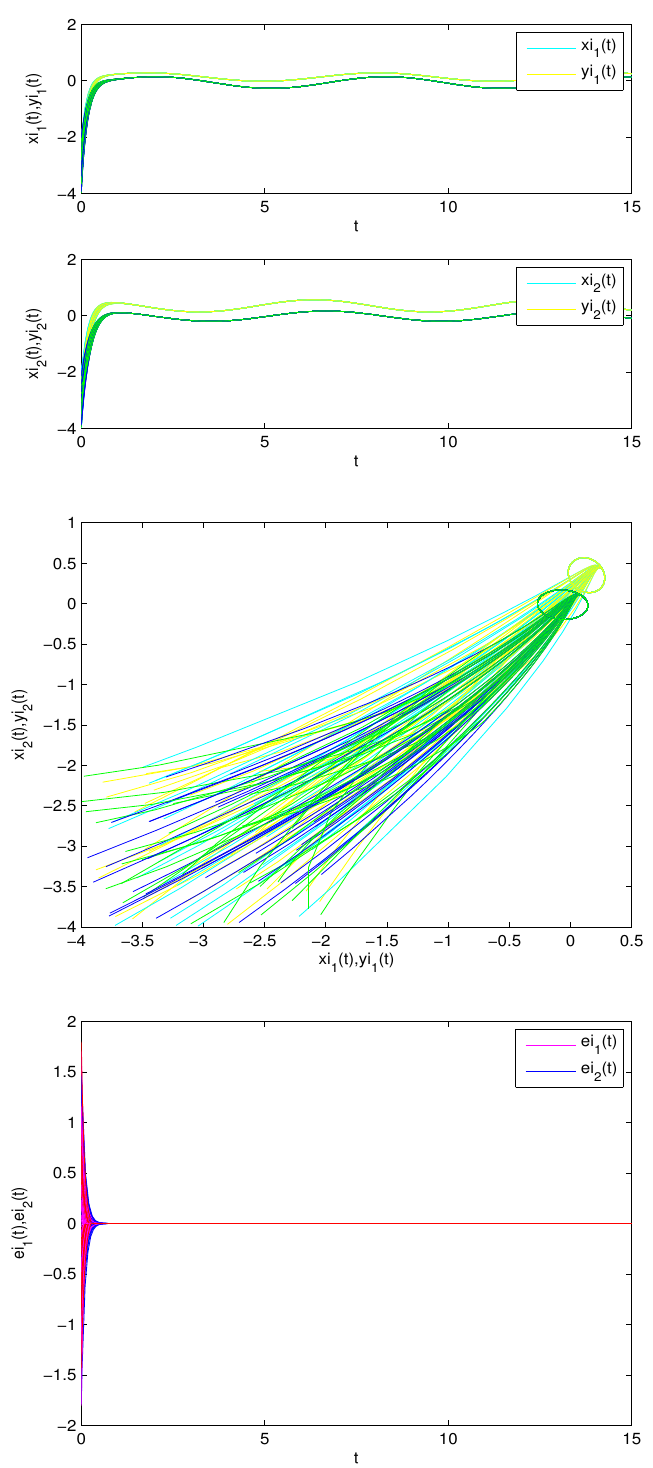
Figure 10. Instantaneous error states for the I part between for the variable ˘ x of (18) and ˘ y of (19) under 30 random initial values for two kinds of